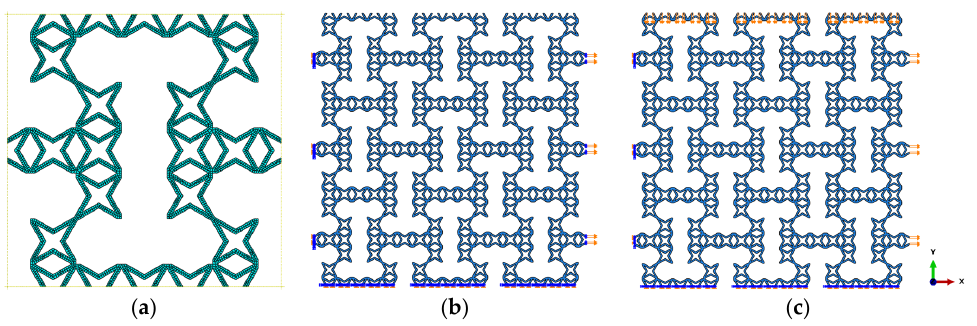
Figure 2. Numerical model description: ( a ) Mesh of one representative unit cell, ( b ) boundary conditions of axial tension along x direction, ( c ) boundary conditions of biaxial shear test.